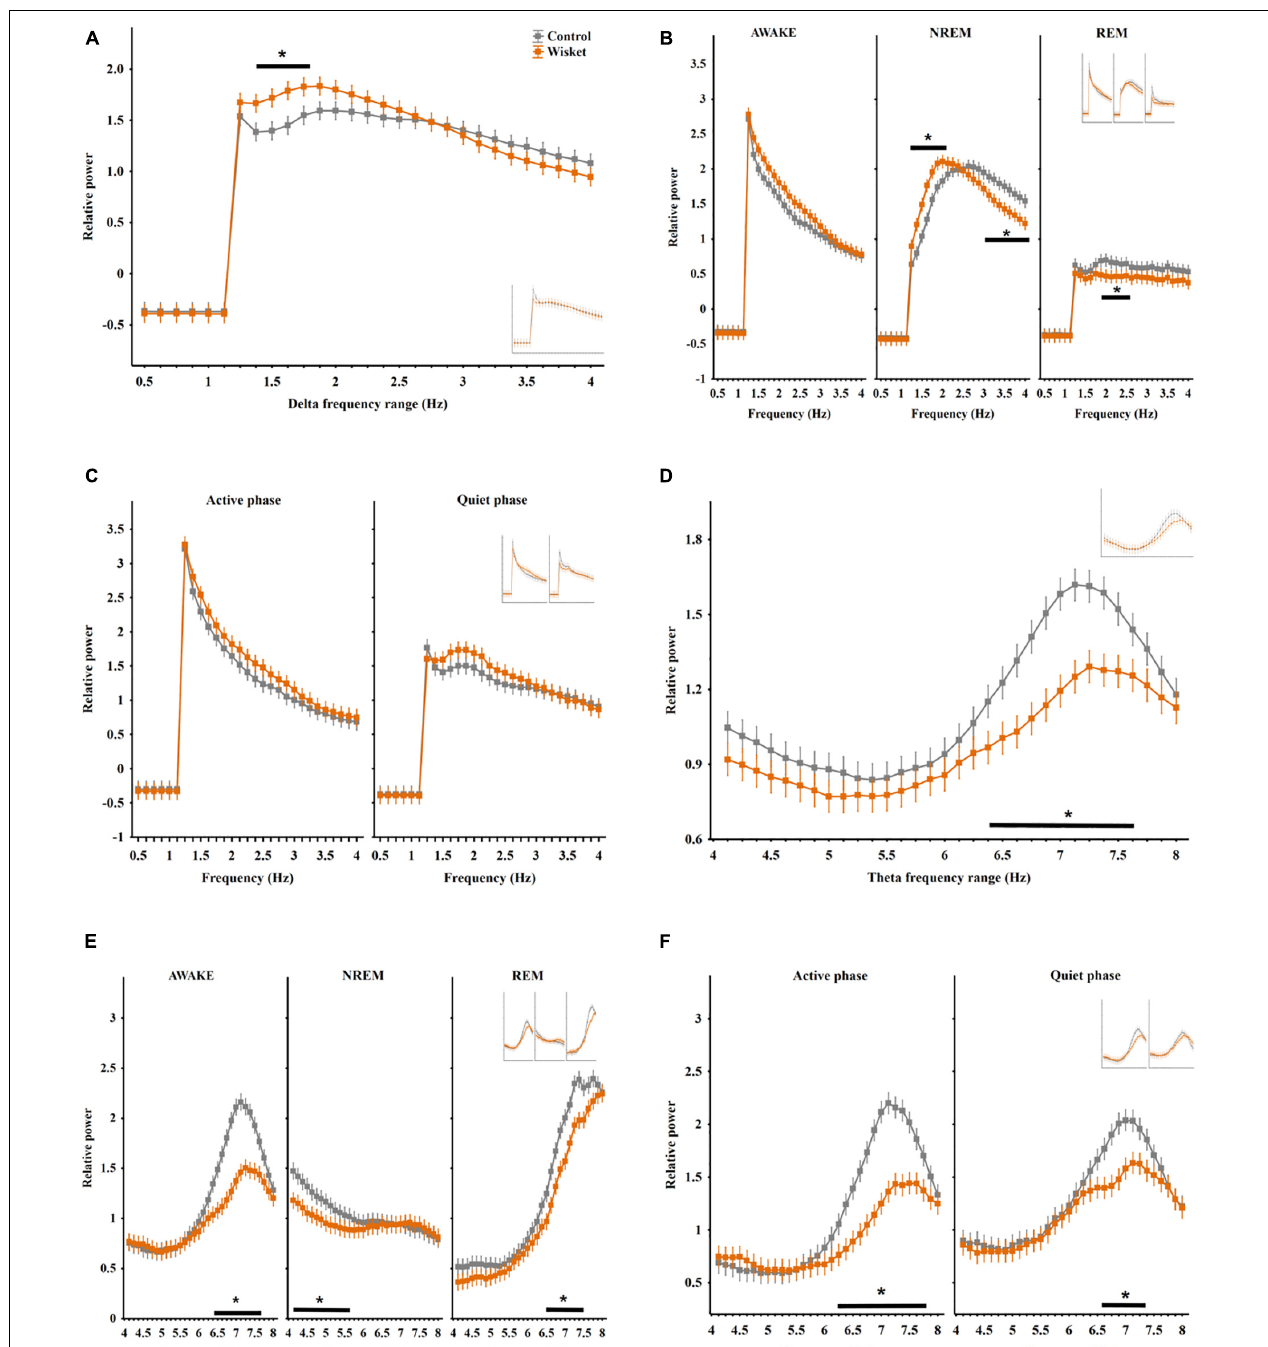
FIGURE 1 | Relative EEG power differences between the two groups at the delta and theta frequency bands. (A) Total relative delta power (0.5–4 Hz). (B) Delta power in different stages. (C) Delta power in active and quiet awake substages. (D) Total relative theta power (4–8 Hz). (E) Theta power in different stages. (F) Theta power in active and quiet awake substages. Curves inserted in reduced size show the results obtained from unmatched control and Wisket animals. The symbol * shows QQsignificant ( p ◦ < ◦ 0.05) differences between the two groups.